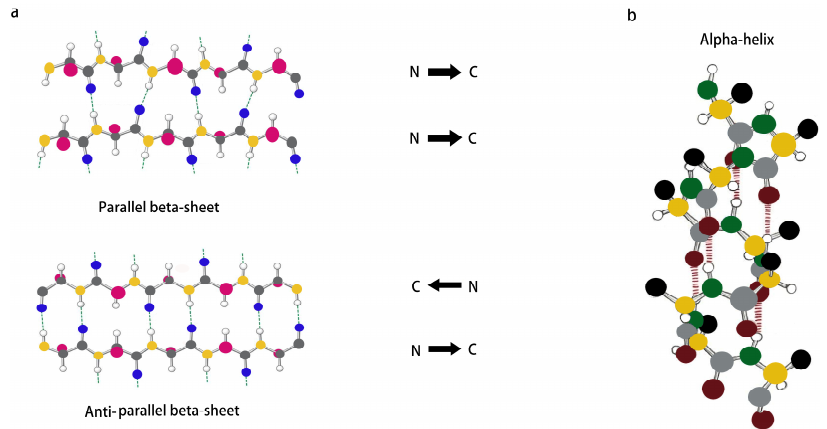
Figure 2. ( a , b ) Schematic representation of β -sheet and α -helix secondary structures .